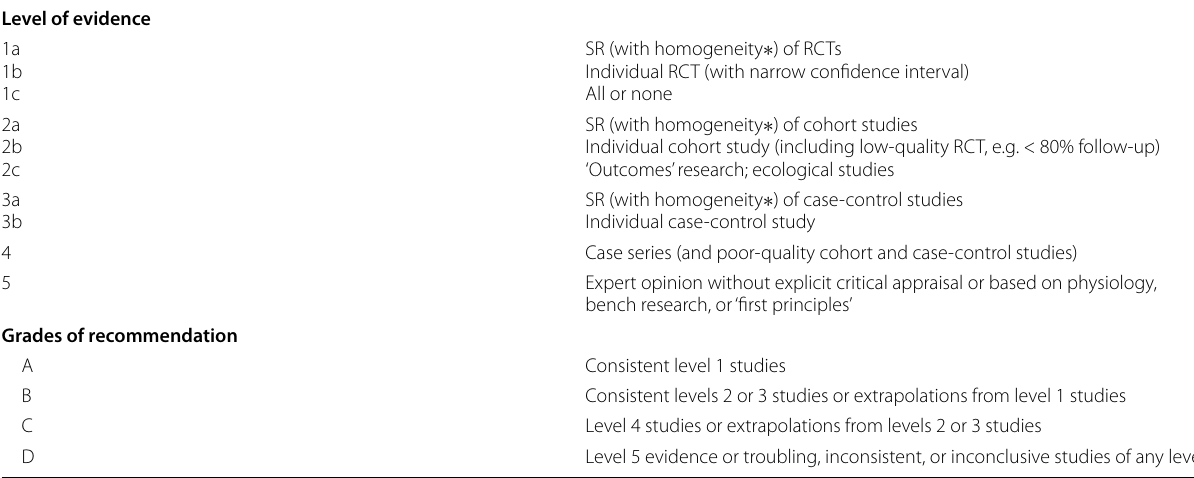
SR Systematic review, RCT Randomized controlled trial